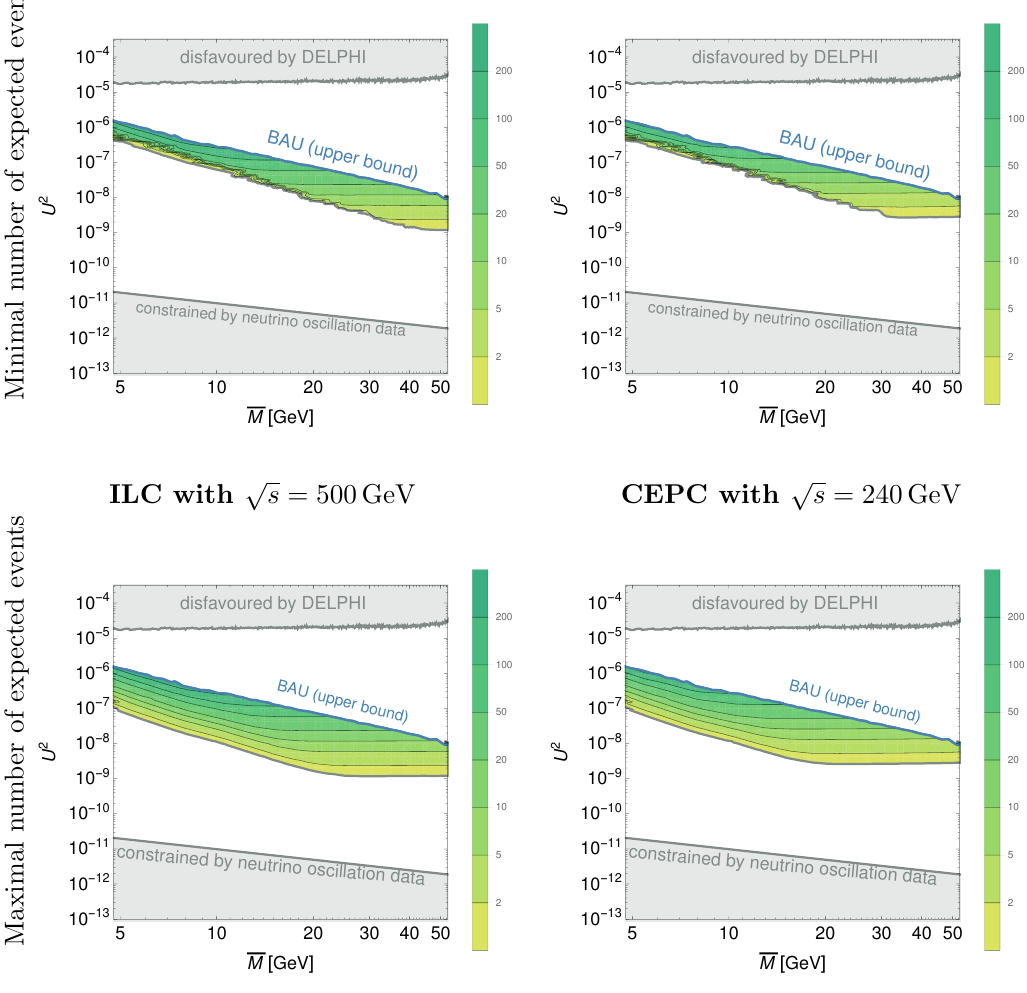
Figure 13 . Minimal (top row) and maximal (bottom row) of expected number of events expected p at the ILC with s = 500 GeV (left column) and at the CEPC with in case of inverted ordering for parameter points consistent with